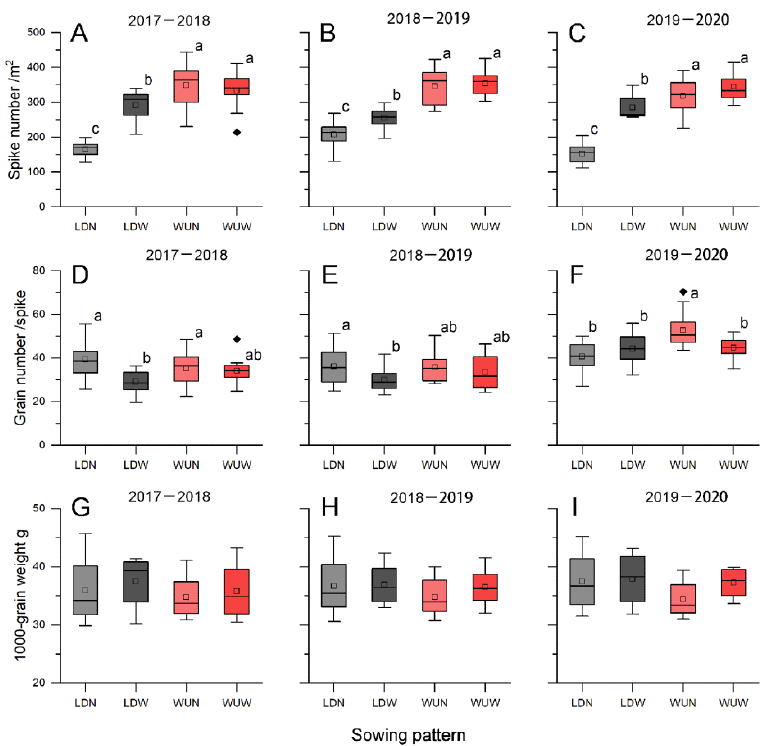
Figure 4. The spike number ( A – C ), grain number per spike ( D – F ) and thousand-grain weight ( G – I